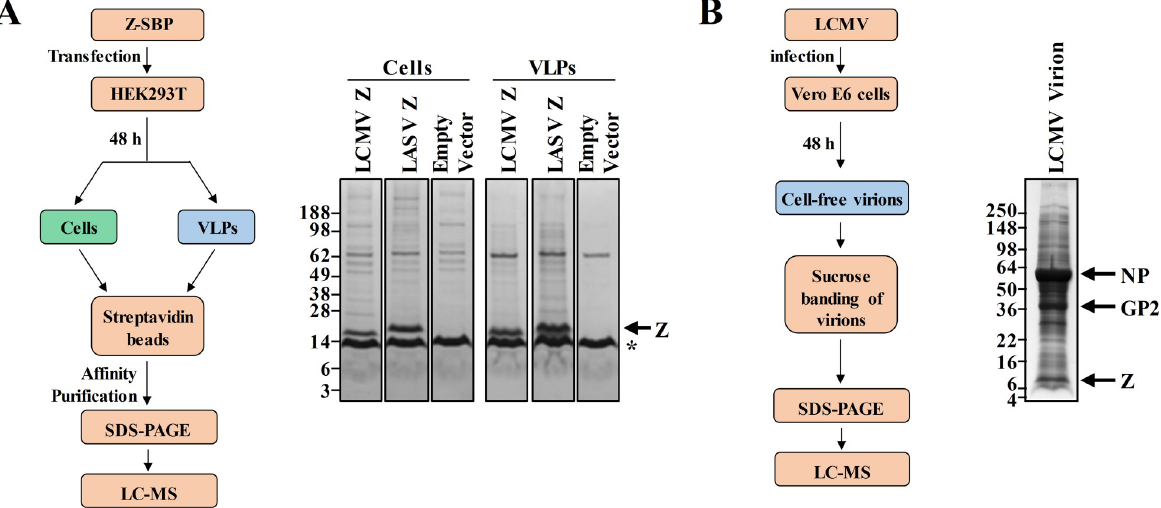
Fig 1. Identification of host proteins that interact with the LCMV and LASV Z matrix proteins or are packaged into LCMV virions. (A) The flow diagram depicts the affinity purification- and mass spectrometry-based approach used to identify human protein partners of LCMV or LASV Z proteins. HEK293T cells were transfected with a plasmid encoding LCMV or LASV Z with a C-terminal streptavidin binding peptide (SBP) tag or an empty vector. Z and its human protein binding partners were affinity purified from cell lysates or cell-free virus-like particles (VLPs) using magnetic streptavidin beads and the captured protein complexes were separated by protein gel electrophoresis and processed for mass spectrometry as described in the Methods. The Coomassie-stained protein gel shown is representative of two independent experiments. (B) The flow diagram shows the sucrose banding- and mass spectrometry-based approach to detect host proteins in LCMV particles. Intact virions of LCMV strain Armstrong 53b produced in Vero E6 cells were sucrose-banded and then subjected to lysis followed by protein gel electrophoresis. The Coomassie stained gel, which was processed for mass spectrometry as described in the Methods, is shown and various viral proteins are indicated.